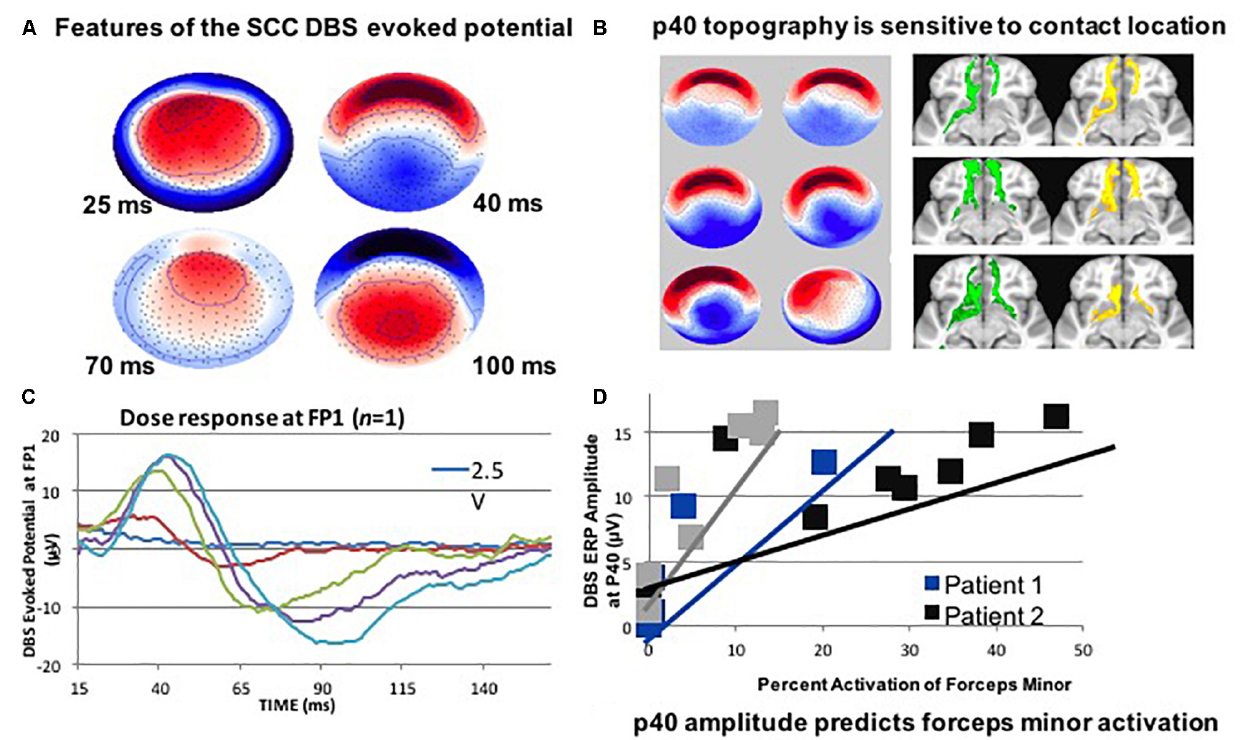
FIGURE 1 | (A) SCC DBS evoked potentials in patients with treatment resistant depression may also be useful. It is less important to hit the visible target; it is more about hitting the correct portion of the connectome. (B) Use DTI: to target structures intraoperatively. (C) Record LFP at the DTI-optimized target. (D) Use high- density EEG: to detect evoked cortical responses for stimulation. This figure adapted from Cho et al.